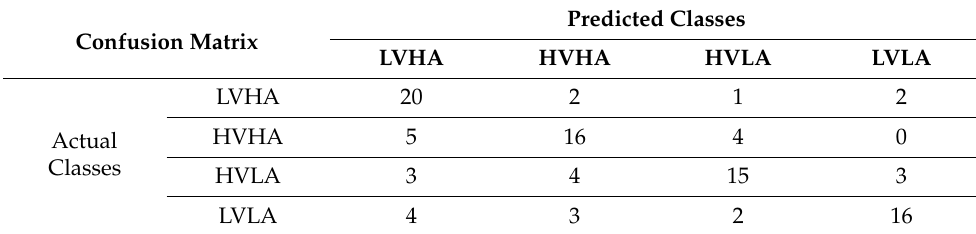
Table 8. Confusion matrix with average ERPs on frontal electrodes with polynomial order fixed at 3.